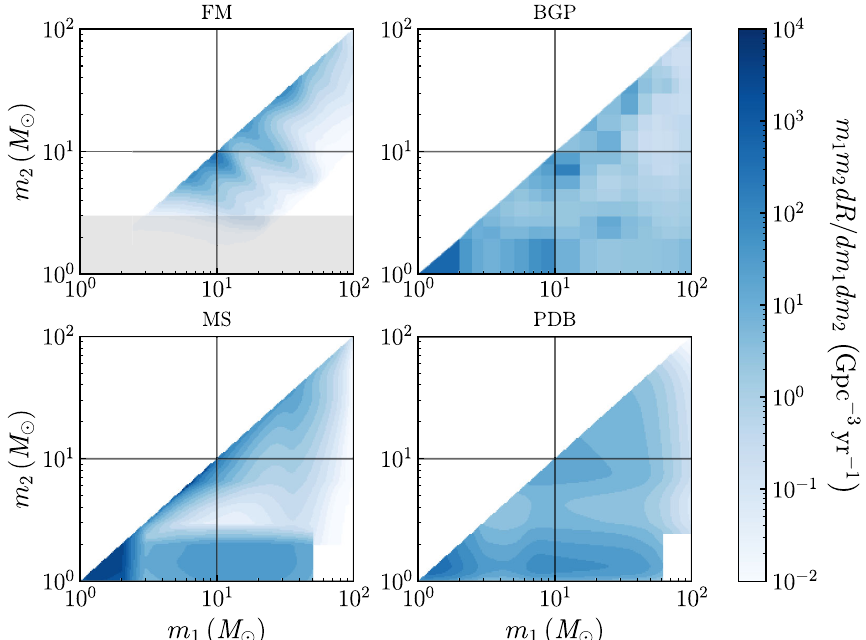
FIG. 3. Rate density versus component masses for different models inferred from events with FAR < 0 . 25 yr − 1 , illustrating consistency on large, coarse-grained scales, but some disagreement and systematics in areas with few observed events. Top left panel: rate density computed with the FM model assuming no redshift evolution, for BBHs only. Modulations along lines of constant chirp mass are apparent. Top right panel: rate density inferred with the BGP model using all compact objects. This model can reproduce observations with localized regions of relatively enhanced rate density. In the BBH region, some regions of enhanced density are commensurate with the FM result. Bottom left panel: rate density inferred with MS. For mergers involving NSs, this model reproduces observations with broad distributions, consistent with smoothing the BGP result. For mergers involving typical BHs, this model strongly favors equal-mass mergers. Bottom right panel: rate density inferred with PDB. This model is also consistent with smoothing the FM result, producing features similar to MS, albeit with less structure in the mass ratio distribution for BBHs, and by construction lacking a peak near 30 M ⊙ .